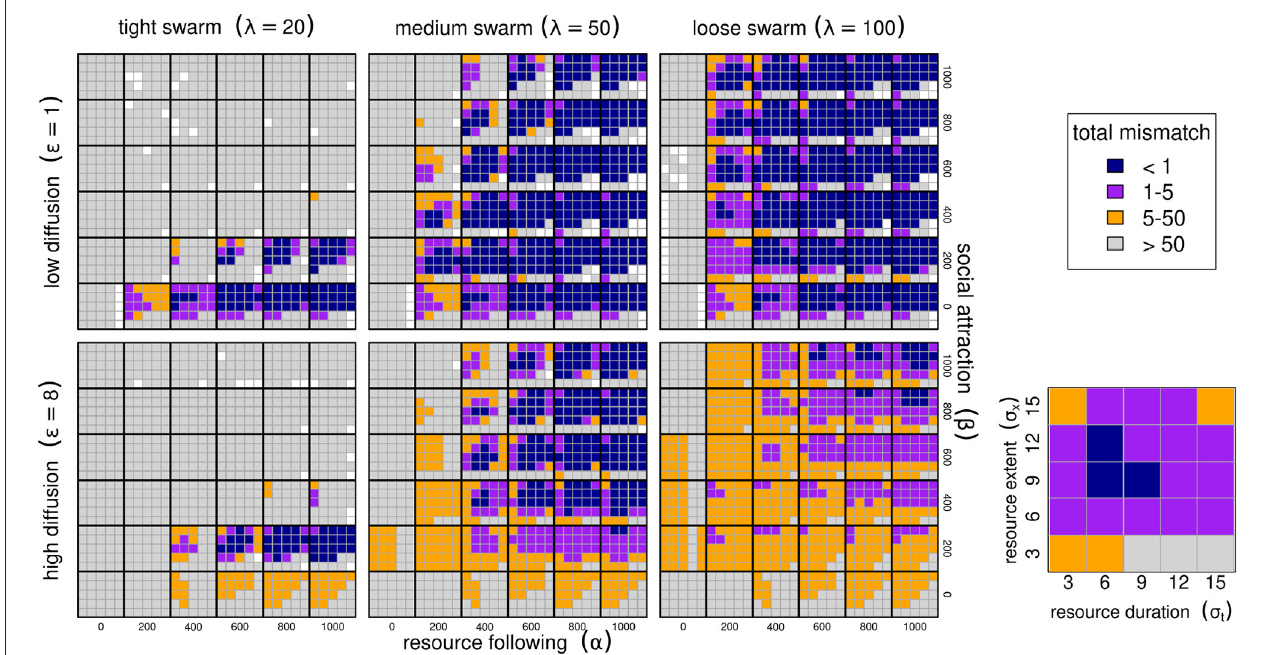
FIGURE 3 | Migration phenology matching across six model parameters. Low and high diffusion ( ε loose swarms ( λ 20,50,100) left to right panels. Within each of these blocks, high values of the resource following parmaeters α from 0 to 1,000 are left to right, = and higher values of the sociality parameter β are bottom to top. Within each of the combinations of ε , λ , α , β , we show results ranging across 5 values of resource duration ( σ t , 3–15 left to right), and 6 values of resource extent ( σ x , 3–15 bottom to top), as in the zoomed-in panel (bottom right; drawn from α λ 100). The color scheme reflects the total mismatch, i.e., the sum of the absolute differences between the migration timing and locations from the resource peak. = The white squares represents parameter combinations where the PDE could not be solved for artifactual numerical reasons, that all correspond to a failed adaptation (high mismatch).